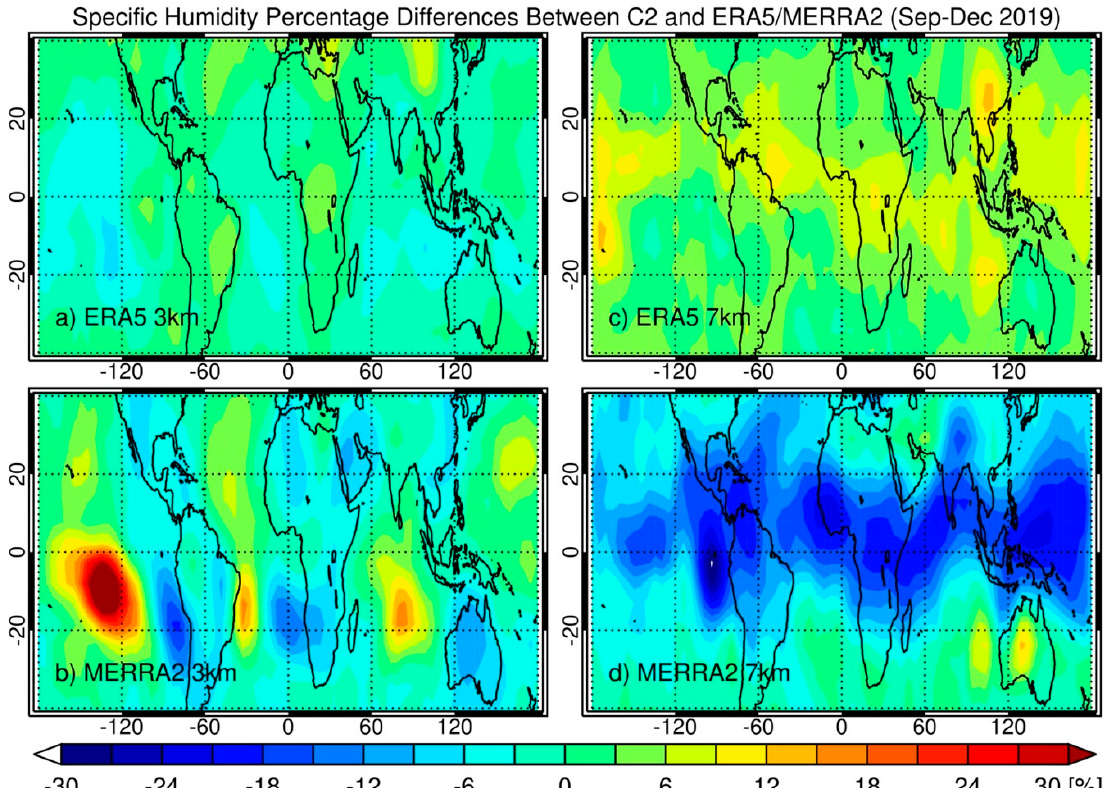
Figure 4. ( a , c ) C2 and ERA5 specific humidity percentage differences at 3 km and 7 km, and ( b , d ) C2 and MERRA-2 specific humidity percentage differences at 3 km and 7 km within 40° N–40° S from September–December 2019.